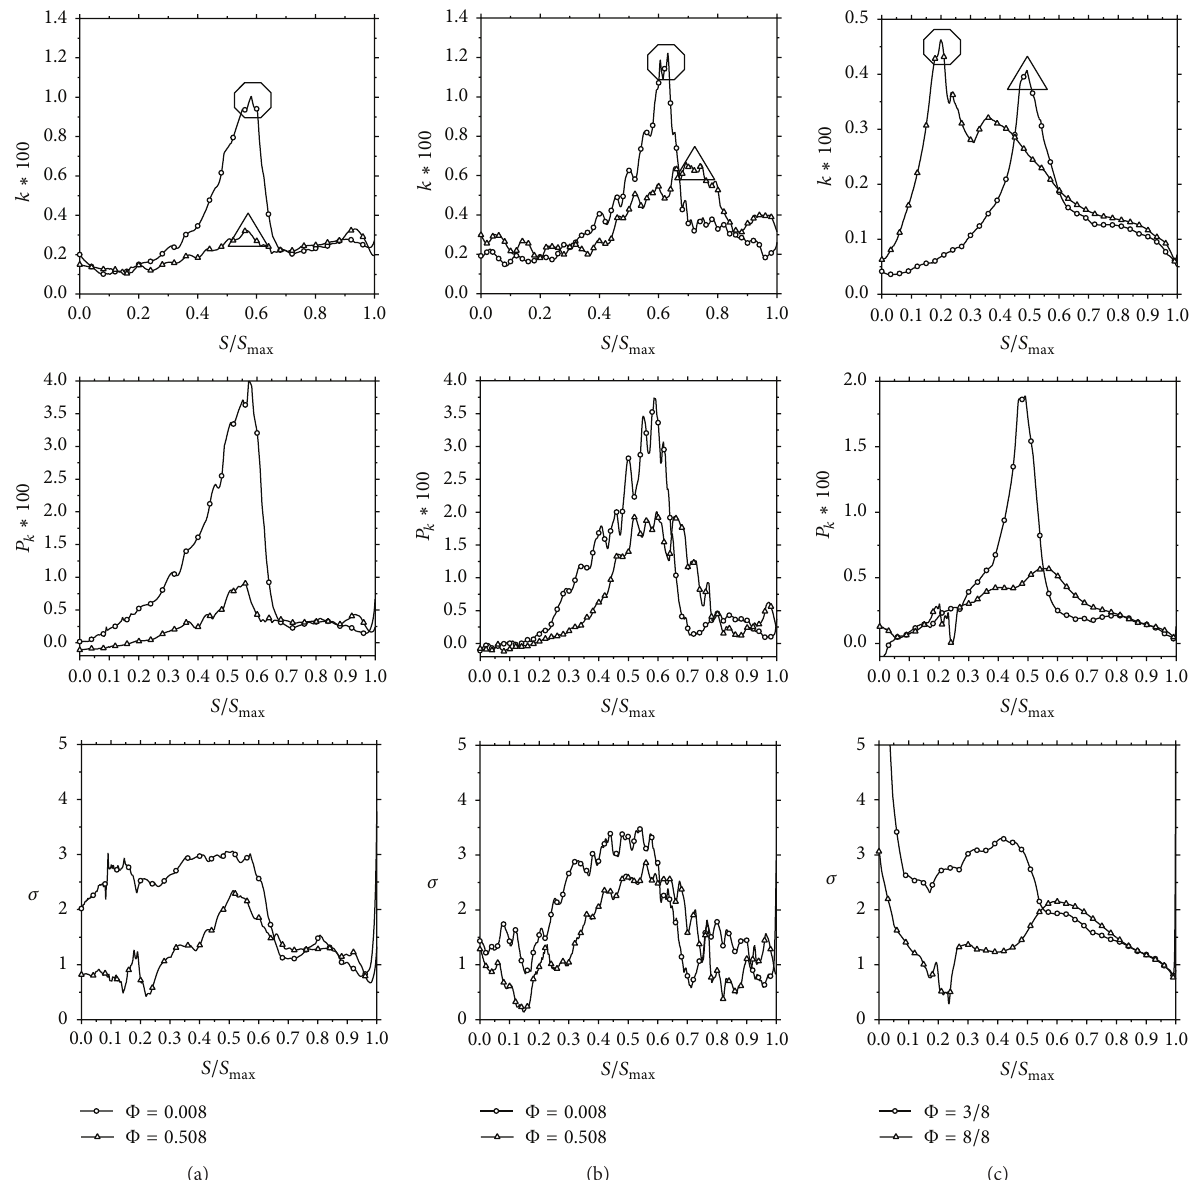
Figure 12: Turbulent kinetic energy, 𝑘 , production rate, 𝑃 𝑘 , and strain tensor eigenvalue, 𝜎 , along two selected wakes: (a) LES: Re = 5.18 × 10 4 , (b) DNS: Re = 5.18 × 10 4 , and (c) LES: Re = 1.48 × 10 5 .